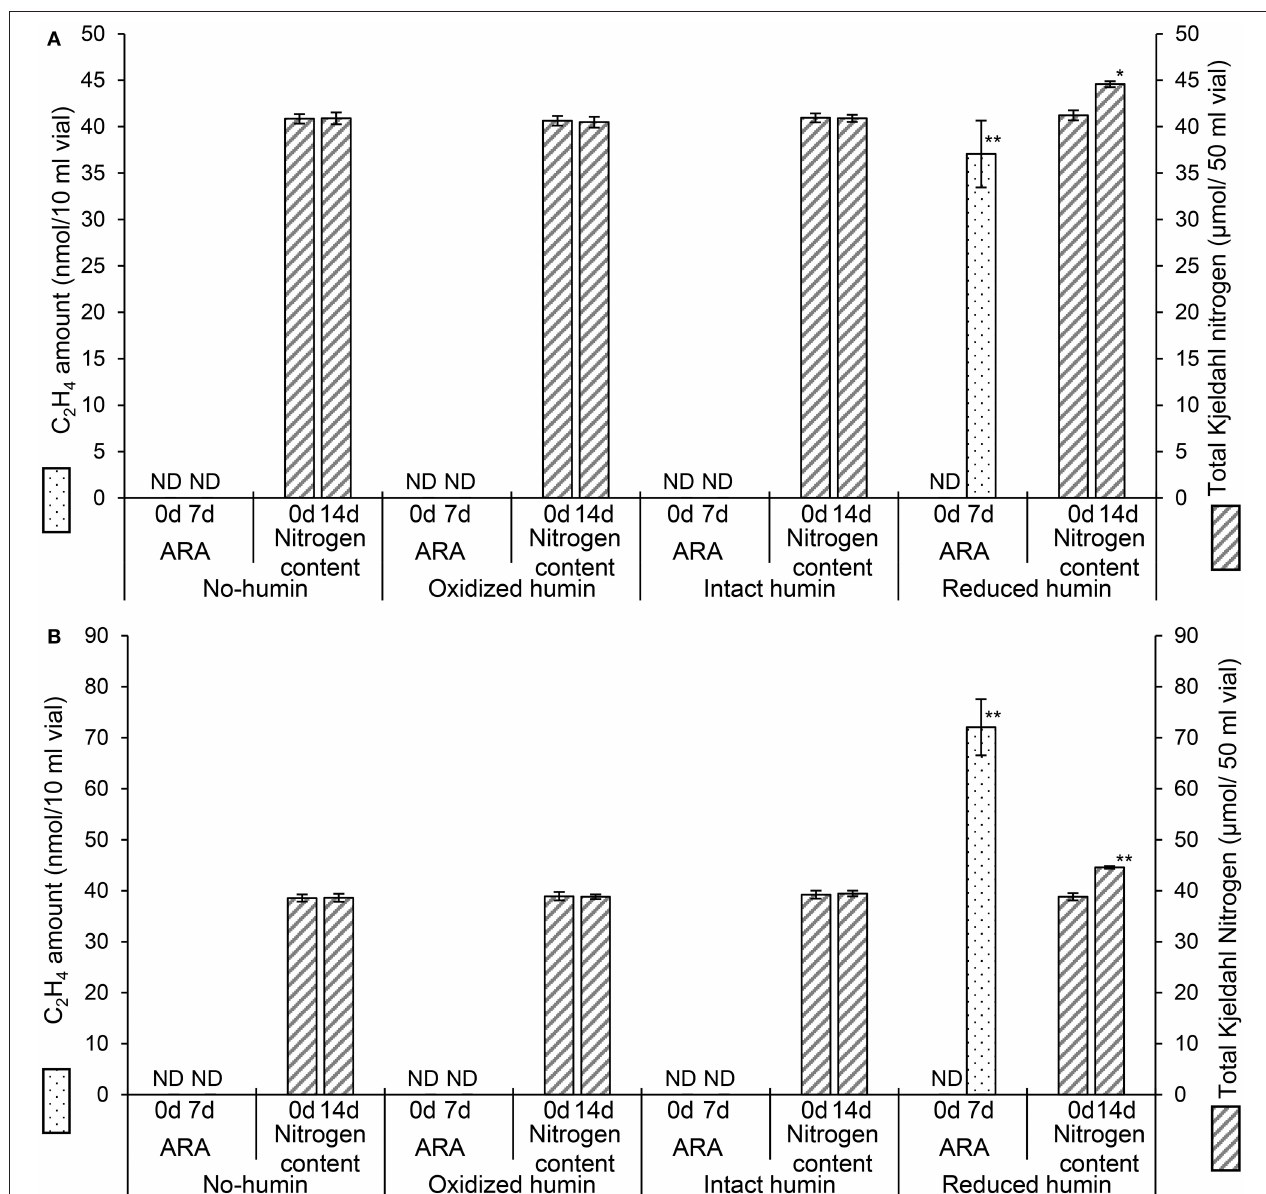
FIGURE 1 | Changes in acetylene reducing activity (ARA), as the amount of ethylene produced, and total Kjeldahl nitrogen (TKN) of the washed and starved C. pasteurianum (A) and A. vinelandii (B) with different redox states of humin during 7 days (for ARA) and 14 days (for TKN) of incubation. No organic carbon source was added to the culture medium. Controls without inoculation showed no ARA and no increase in nitrogen content (data not shown). ND: not detected. Symbols “ * ” and “ ** ” denote significant differences at p < 0.05, and p < 0.01,